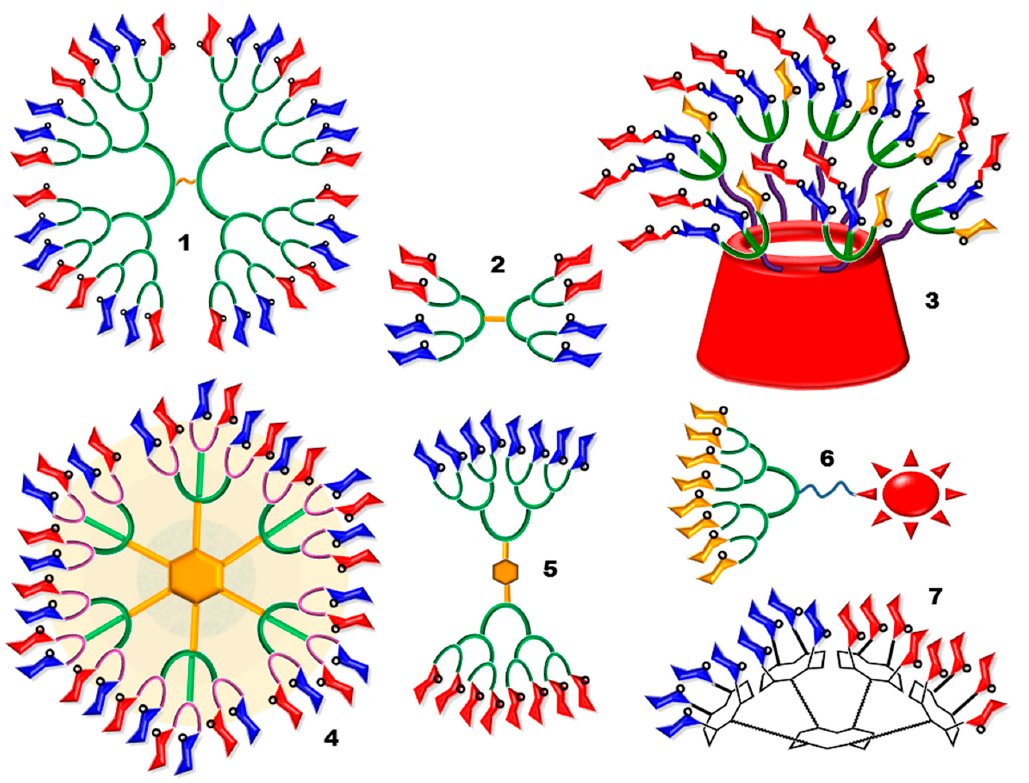
Figure 2. Architectural structures of common heterofunctional glycodendrimers: 1 : sugars are randomly ligated on the surface of pre-formed dendrimers; 2 : Janus glycodendrimers; 3 : heterofunctional dendrons attached to β -cyclodextrin scaffolds; 4 : onion-peel heterofunctional glycodendrimers of precise distribution; 5 : alternative structural Janus glycodendrimers using aromatic as scaffolds; 6 : glycodendrimers with probes at the focal point; and 7 : heterofunctional glycodendrimers mounted on cyclic peptides used as cancer vaccine candidates.